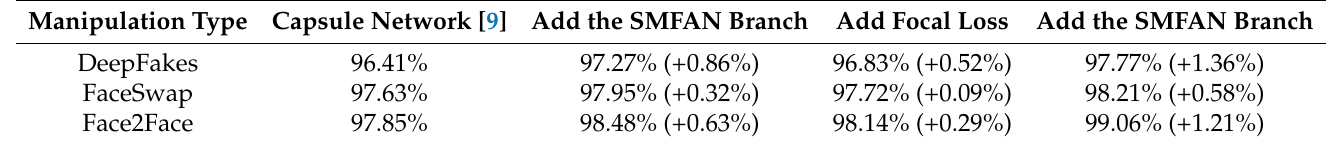
Table 4. Comparison of accuracy of introducing the SMFAN branch and focal loss on different manipulation types. Manipulation Type Capsule Network [9] Add the SMFAN